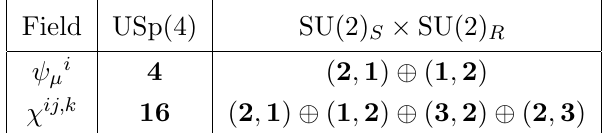
Table 2 . Decomposition of the SL(5) EFT fermionic degrees of freedom under SU(2) S (cid:2) SU(2) R . Those in the adjoint of the SU(2)-structure group form the vector multiplets (with A = 1 ; : : : ; n